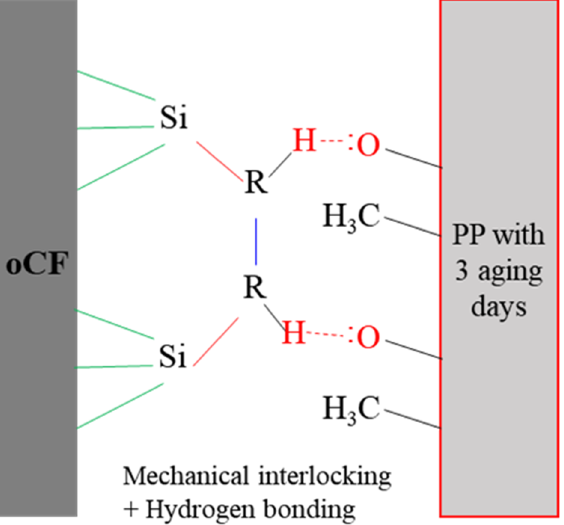
Figure 8. Schematic of the hydrogen bonds between oxidized PP and silane layer of oCF.